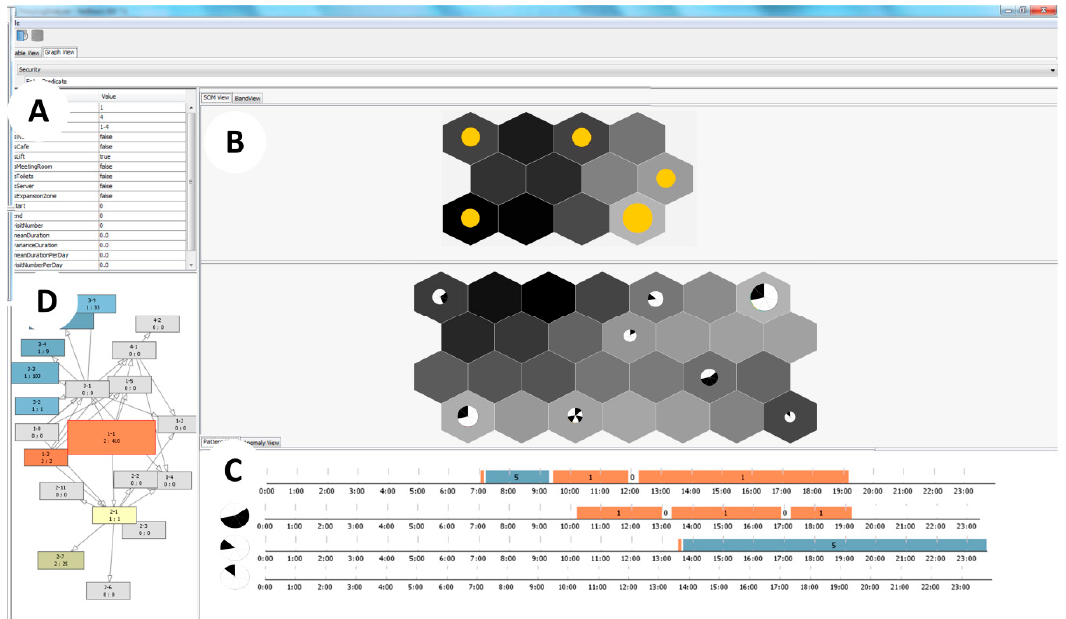
Figure 8. The analytical dashboard designed to support the proposed employees’ movement analysis.